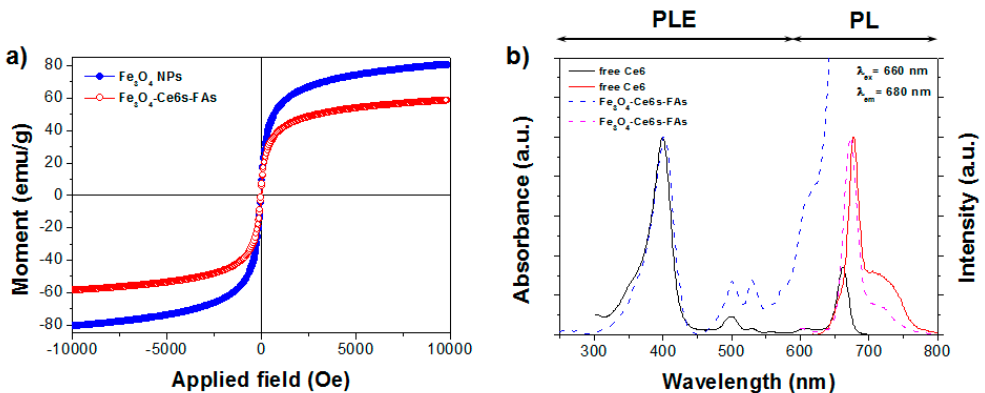
Figure 2. Magnetic and optical properties of the cholrin6- and folic acid-conjugated magnetite (Fe 3 O 4 -Ce6-FA) nanoparticles. ( a ) Room temperature magnetic hysteresis loops of pure Fe 3 O 4 and Fe 3 O 4 -Ce6-FA nanoparticles; ( b ) Photoluminescence and photoluminescence excitation spectra of free Ce6 and the Fe 3 O 4 -Ce6-FA in THF.